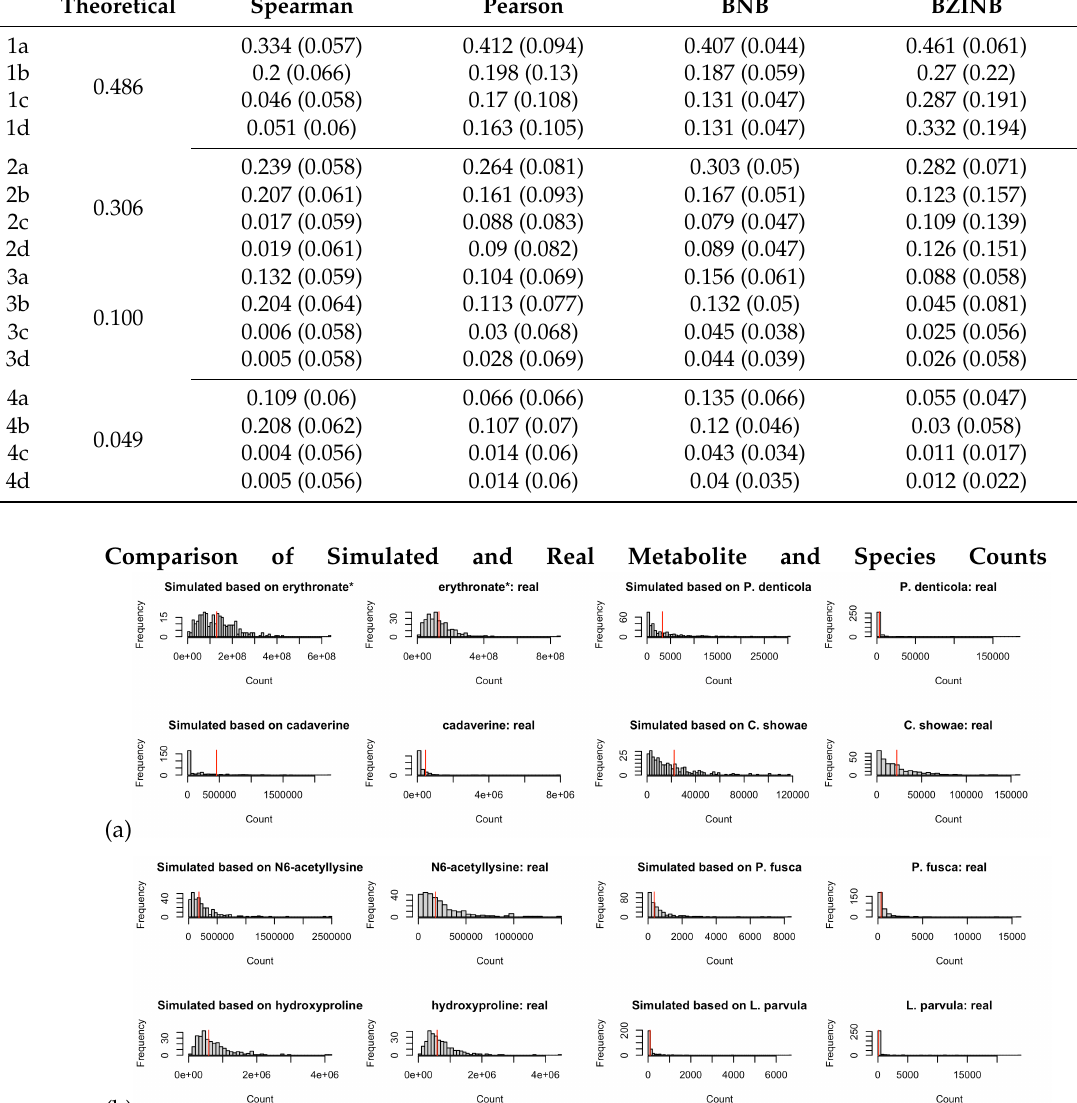
models fitted on the real data) and the real data. If the real data have less than 50 out of 289